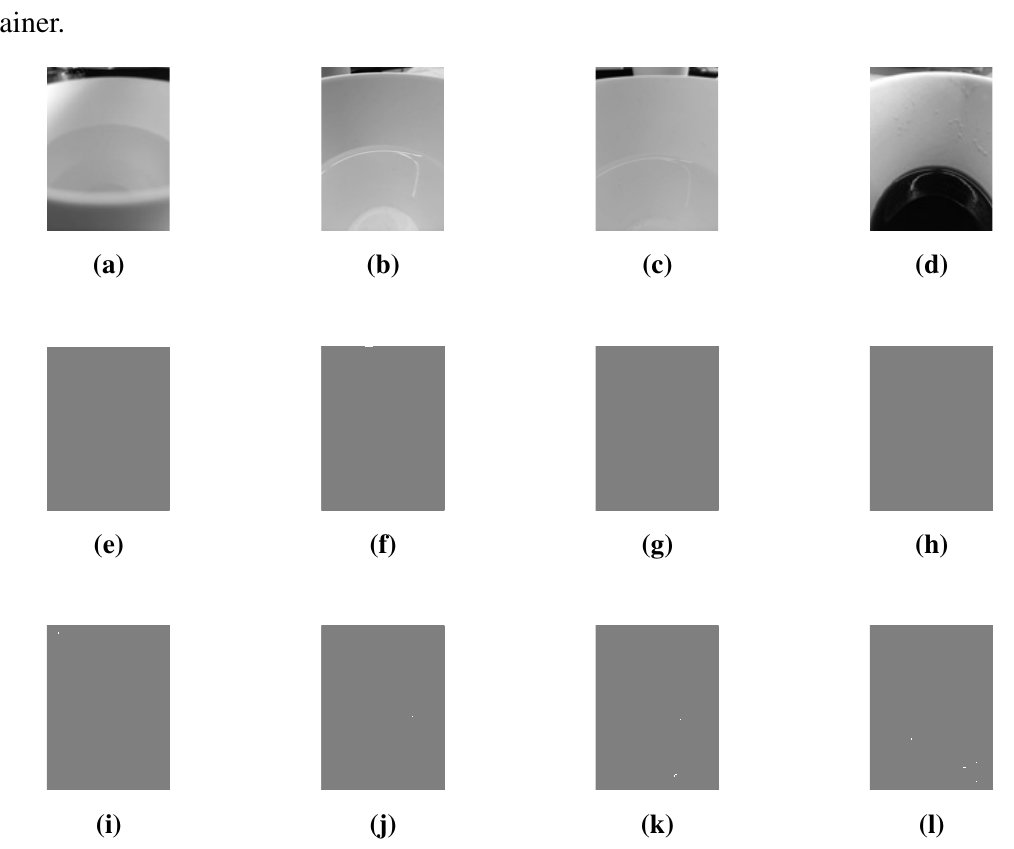
Figure 3. Images with their corresponding edges. ( a – d ) Raw images with liquid at different levels; ( e – h ) Default Sobel Edge detection, thresh = 0 . 005 ; ( i – l ) Default Canny Edge